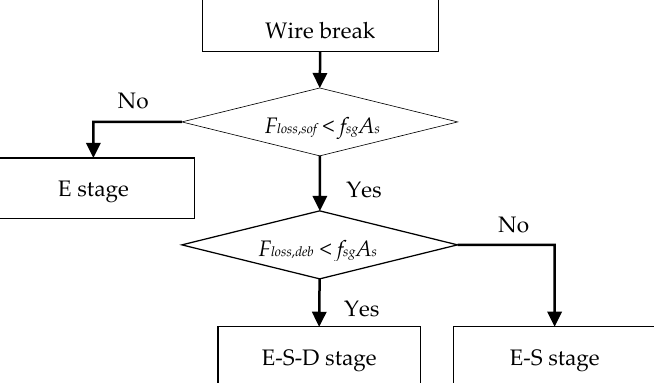
Figure 7. The process of determining the status of the interface after a wire break.